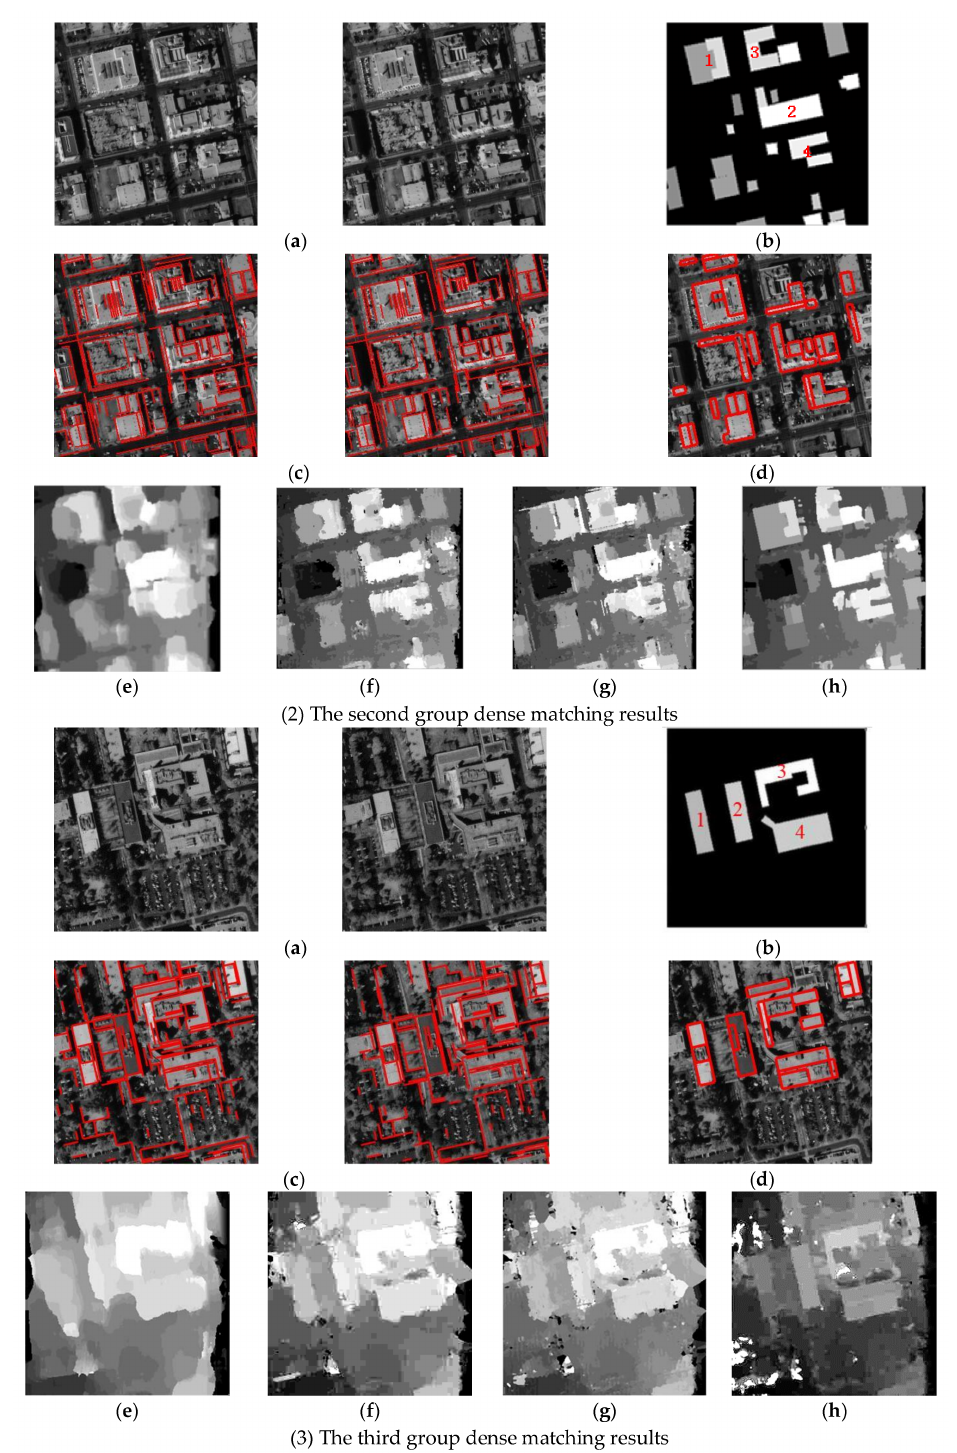
Figure 15. The comparative experiment results of matching disparity map, ( a ) the original stereoscopic image pairs, ( b ) the truth of building objects in the disparity map, ( c ) edge line matching result, ( d ) building outlines by our fusion method, ( e ) matching results by Di’s method [12], ( f ) matching results by J’s method [13], ( g ) matching results by A’s method [18], ( h ) matching results by our ECAOC